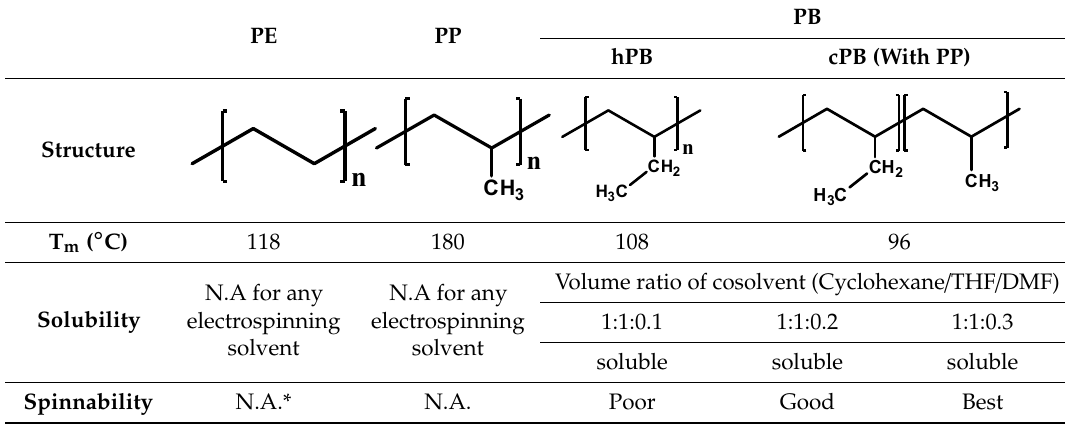
Table 1. Summary of several properties of PE, PP and PB.